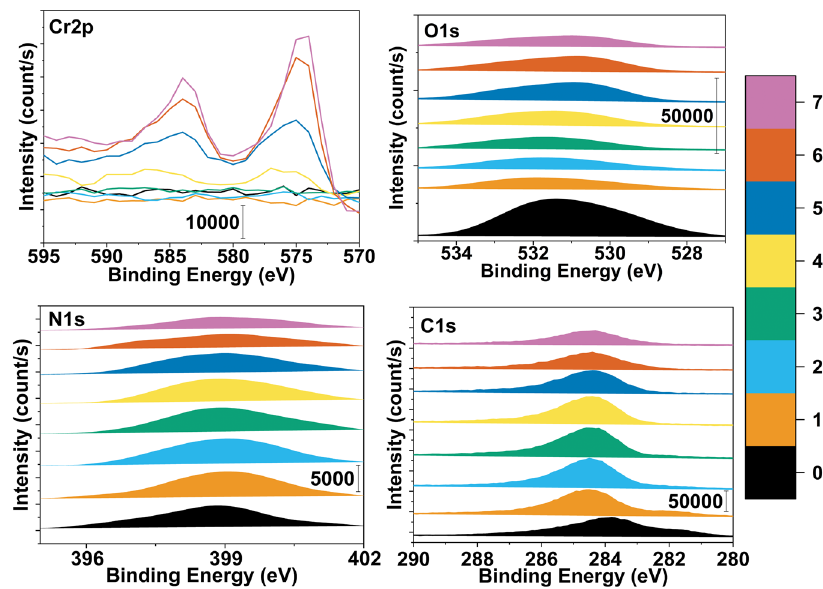
Fig. 6 Layer by layer binding energies of the linked-PDA surface. Numbers represent the etching levels 0 – 7 which equal to 0, 10, 20, 30, 60, 80, and 120